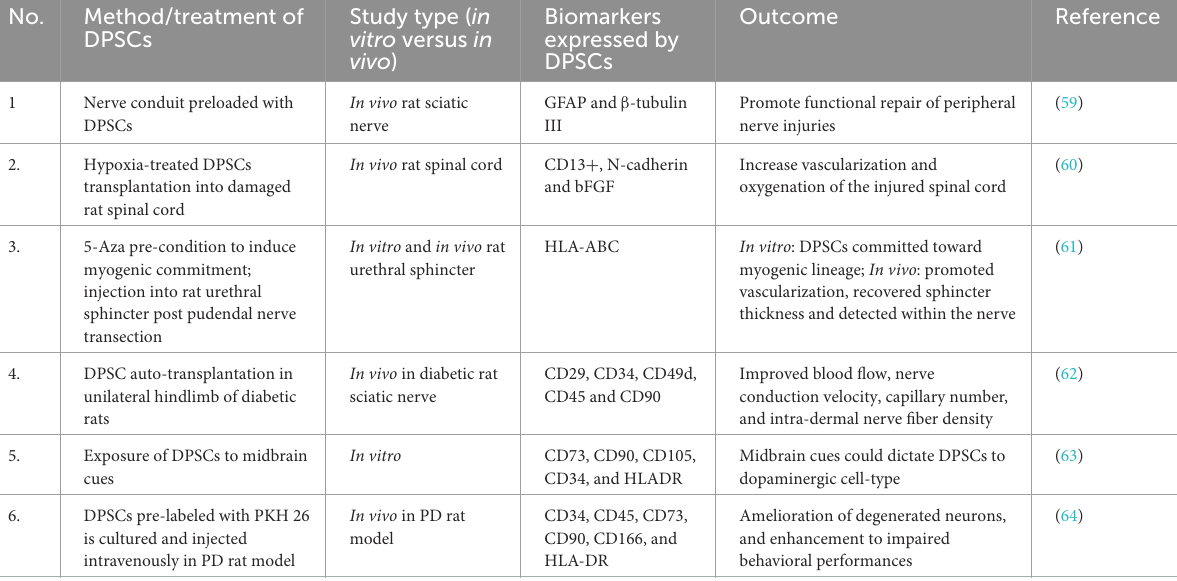
TABLE 2 Several current studies involving the application of DPSCs in nerve regeneration.